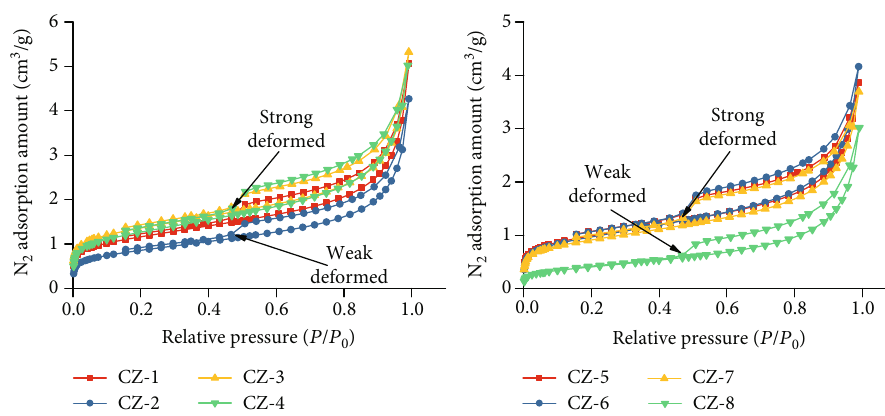
Figure 2: N adsorption-desorption isotherms of the Lujiaping shale. 2